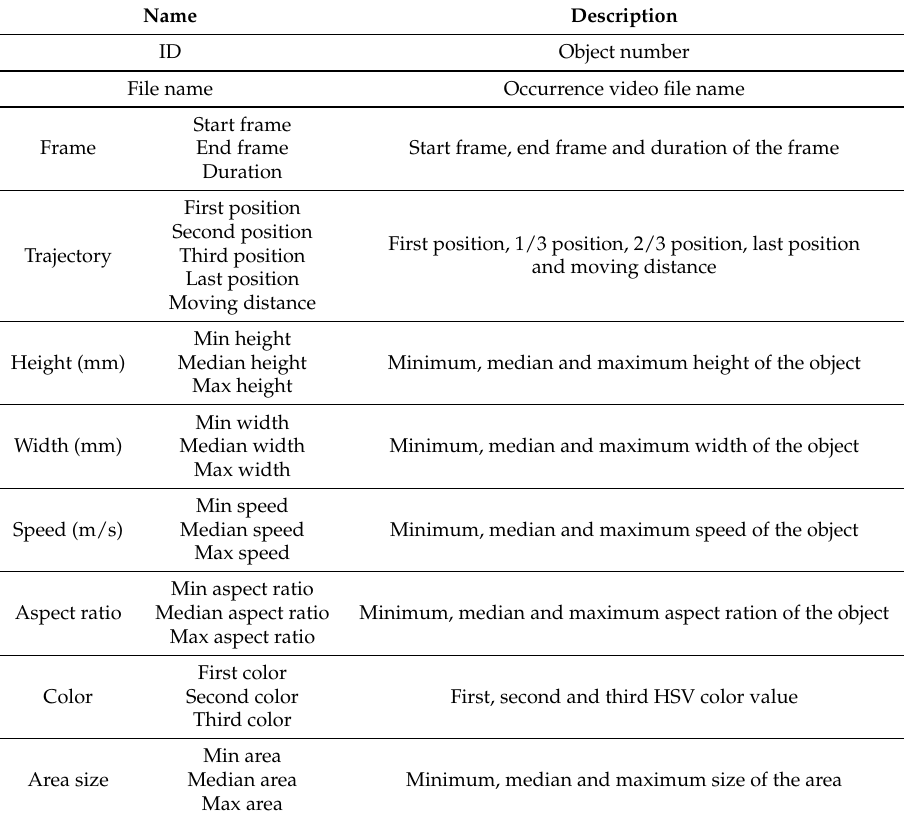
Table 1. Object metadata